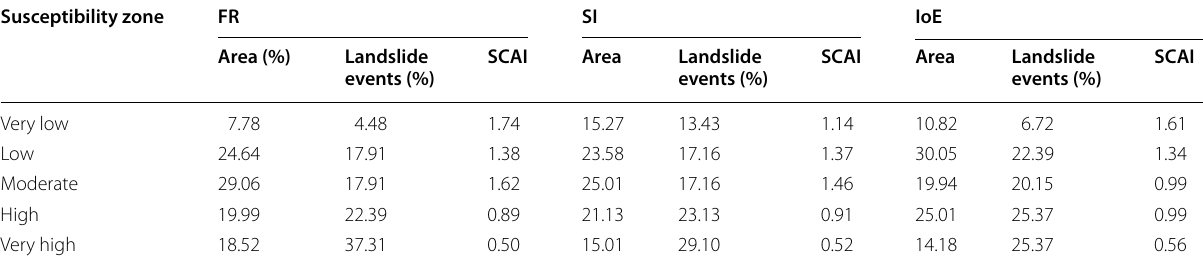
Table 5 SCAI value for each landslide susceptibility zone Susceptibility